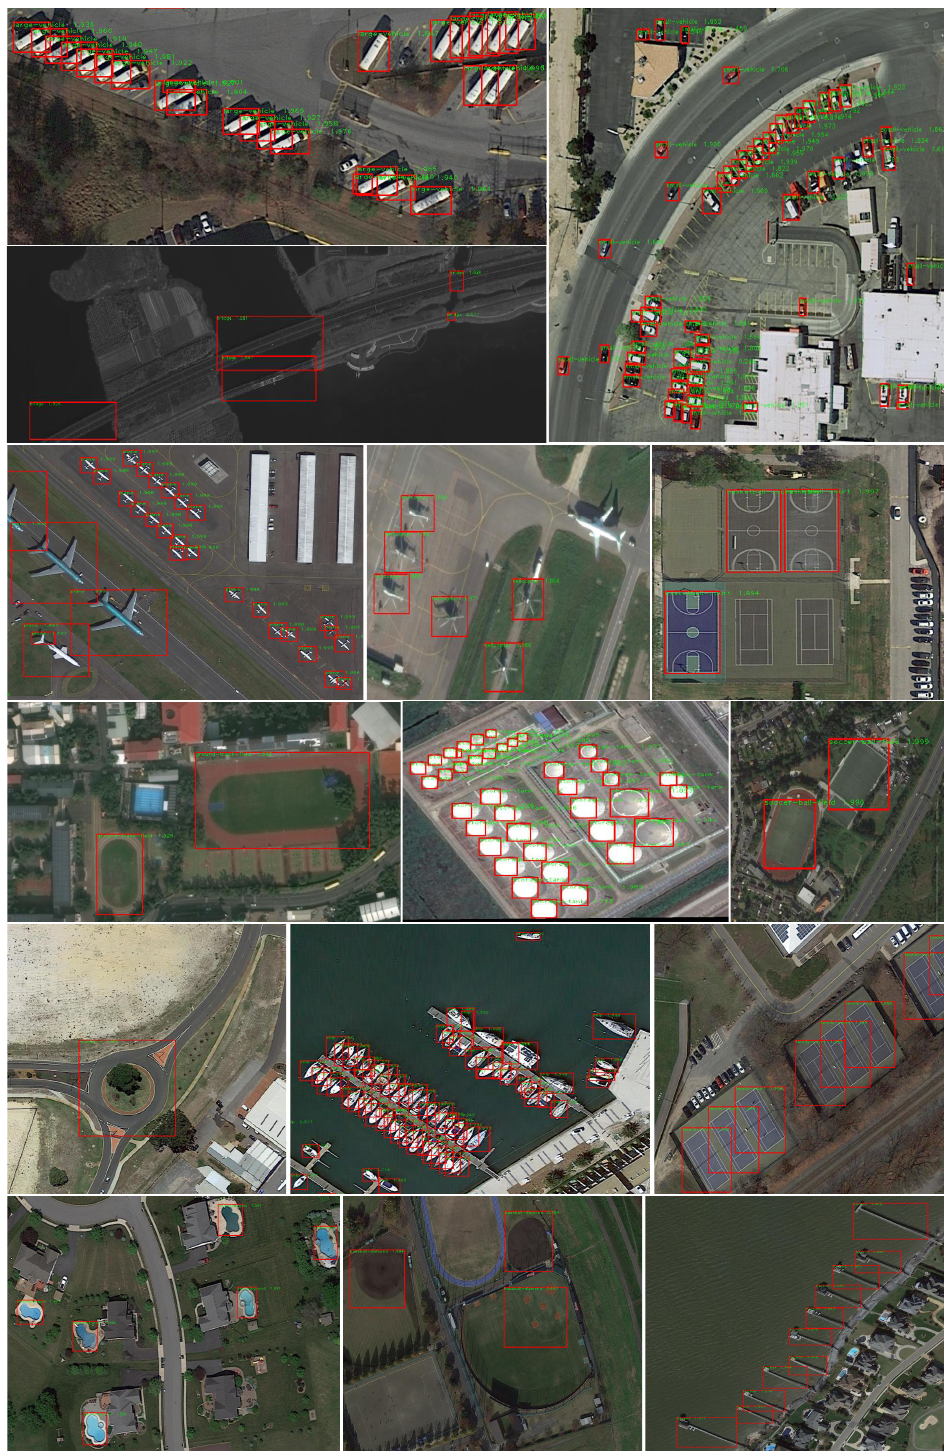
Figure 5. Outputs of HBB prediction on test images of DOTA